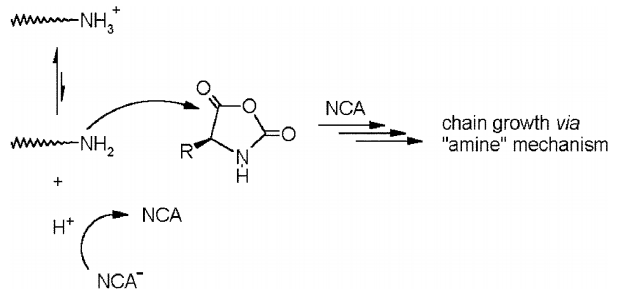
Figure 13. Tentative mechanism of the ring-opening polymerization of NCAs (ZLLys, R = (CH 2 ) 4 NHC(O)OCH 2 C 6 H 5 ) using primary amine–hydrochlorides (chloride ions omitted). Reproduced with permission from reference [68].